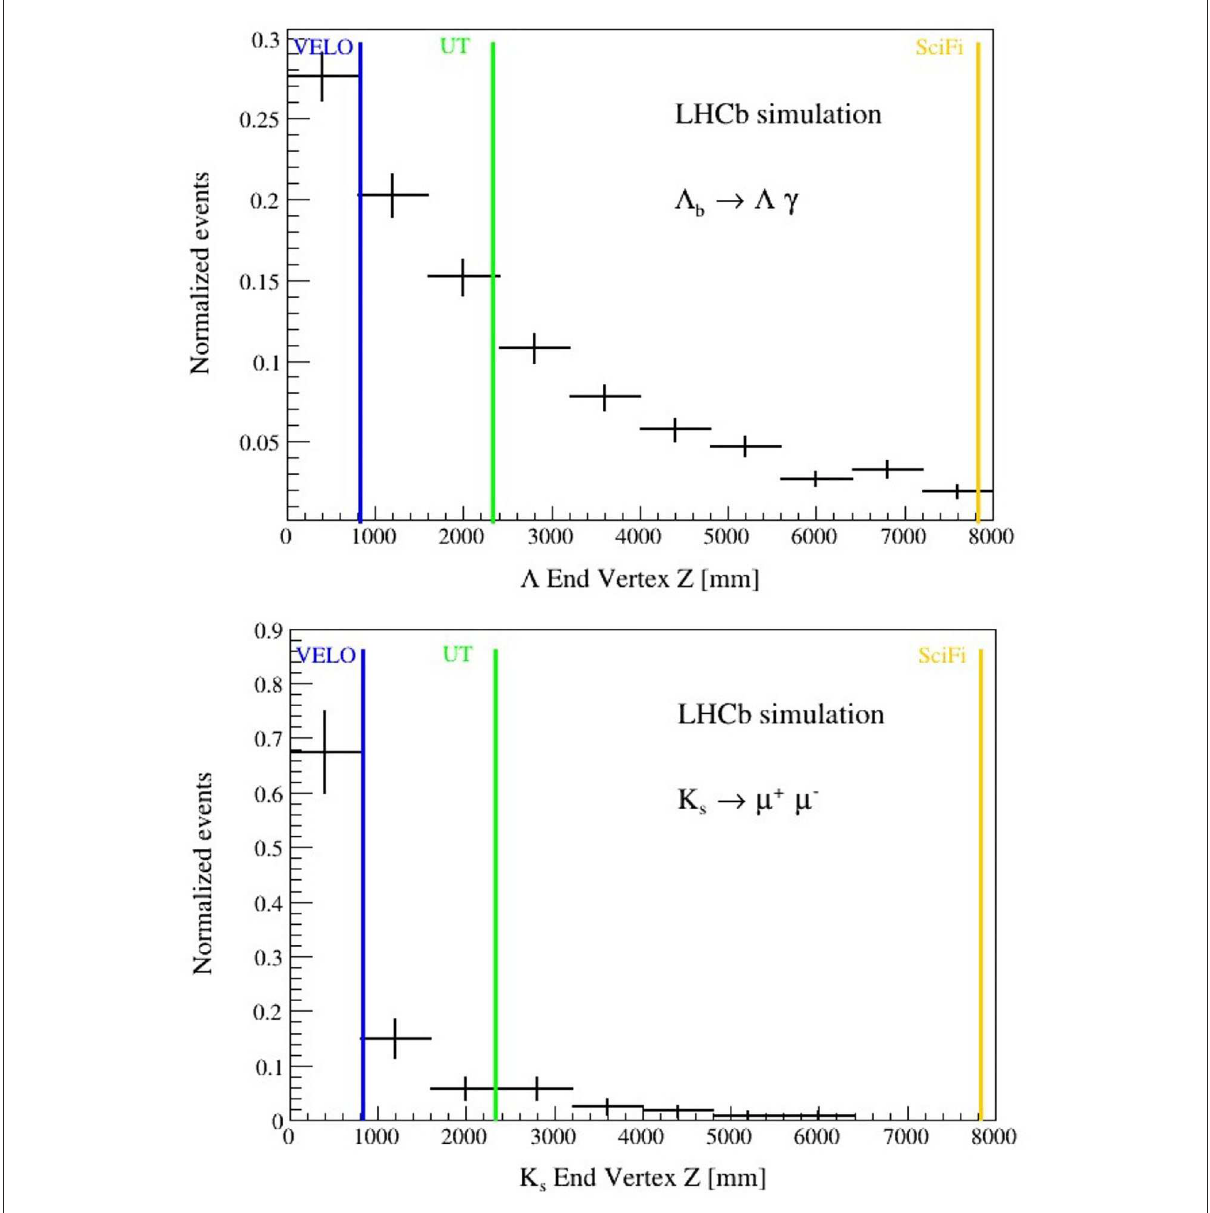
FIGURE12 3 0 (top) and K 0 S (bottom) reconstructible candidates as function of the decay vertex position. The 3 0 candidates decay into a pion and a proton. The K 0 S candidates decay into two muons of opposite charges. Vertical color lines indicate the positions of the Velo, UT, and SciFi detectors in the Z-axis.